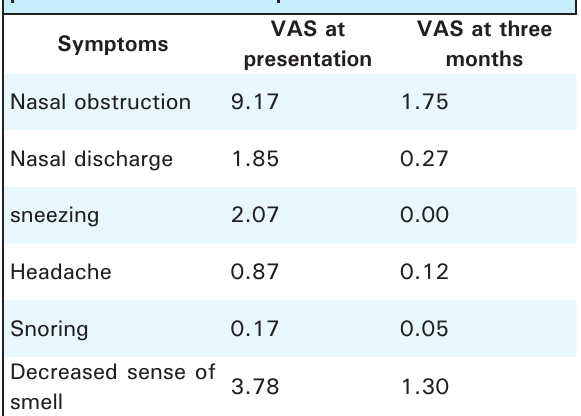
Table 1. Visual analogue scale (VAS) score at presentation and follow up visit.